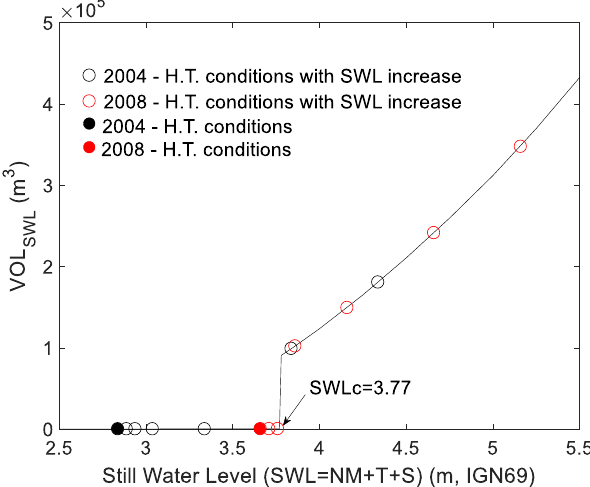
Figure 5. Inland water volume obtained using the bathtub method (with connection to the sea). The filled black and red circles indicate the high-tide conditions (still water level) of the 2004 and 2008 events. The black and red empty circles indicate the volume obtained for larger still water levels, corresponding, for instance, to climate change-induced sea-level rise scenarios of [0.05 0.1 0.2 0.5 1 1.5] m. The arrow indicates the still water level threshold (SWL C ) above which overflow occurs.